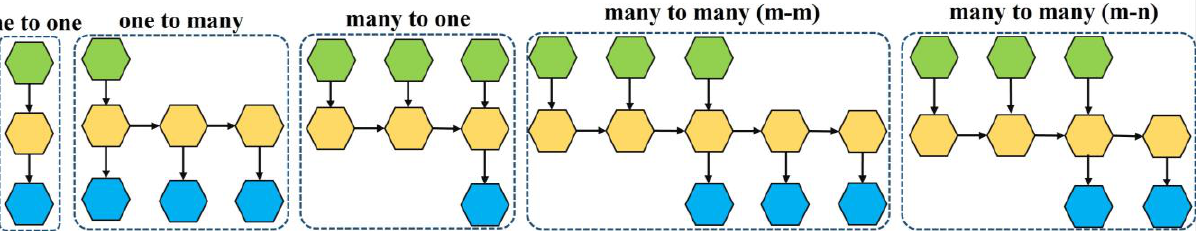
Figure 3. Five types of mapping for LSTM.